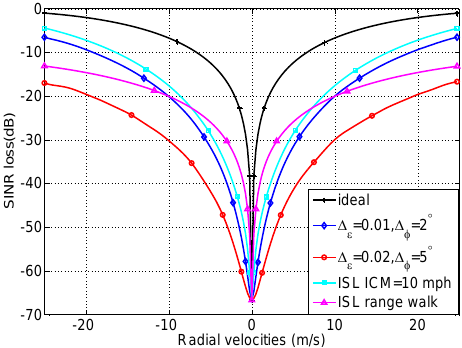
Figure 7. The impact of nonideal factors on the space-time clutter eigenspectrum.